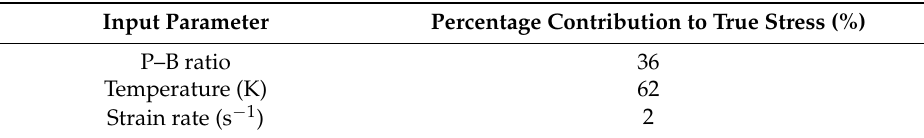
Table 4. Sensitivity analysis of true stress of AZ31